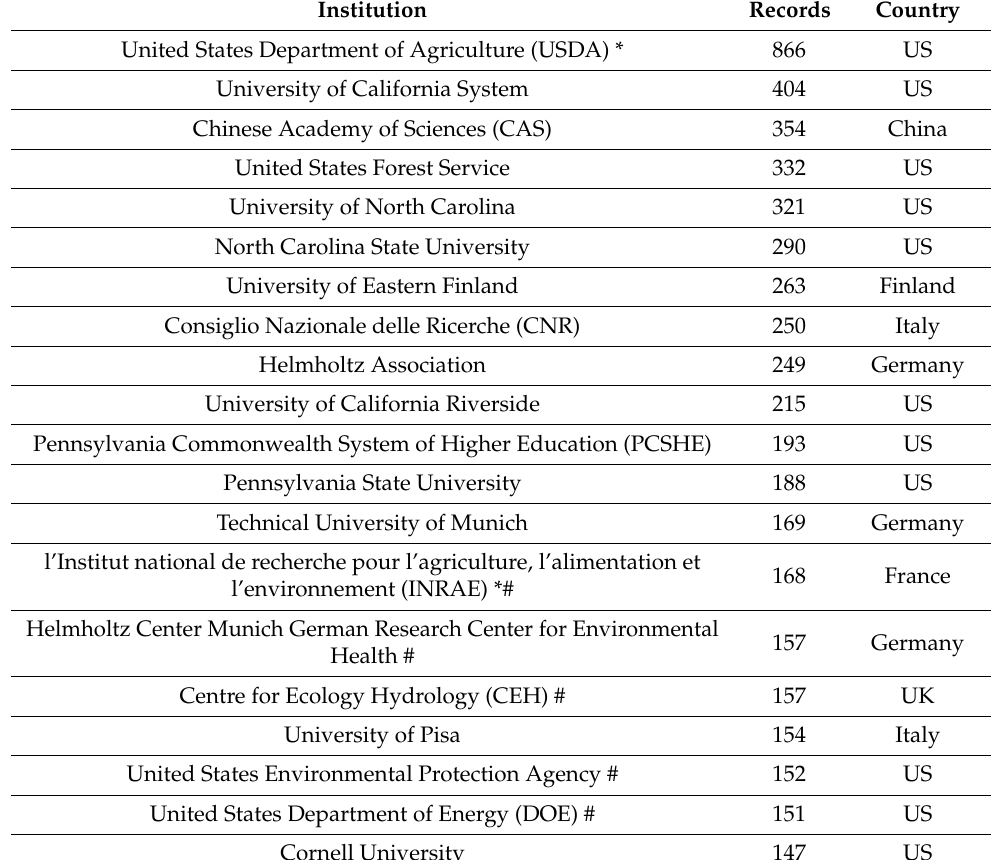
Table 1. Ranking of the 20 most productive institutions in the research field of ozone in